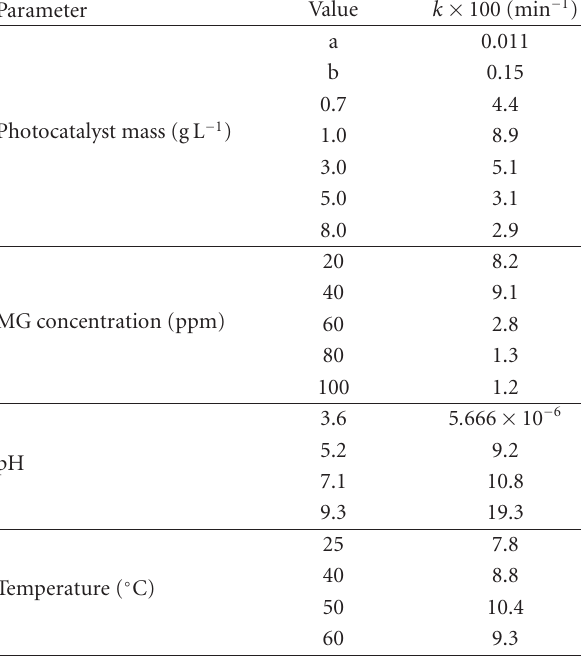
Table 1: Reaction rate constant of MG photodecolorization as a function of various experimental